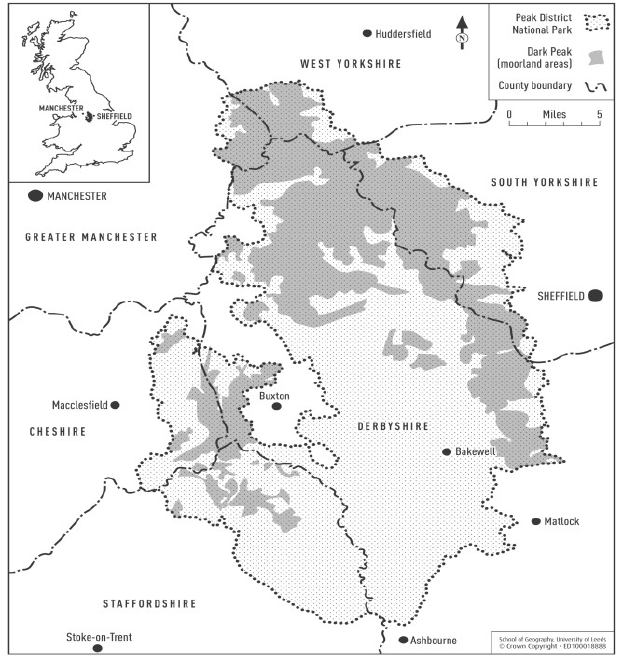
Fig. 1 . Map of Peak District National Park showing the Dark Peak area